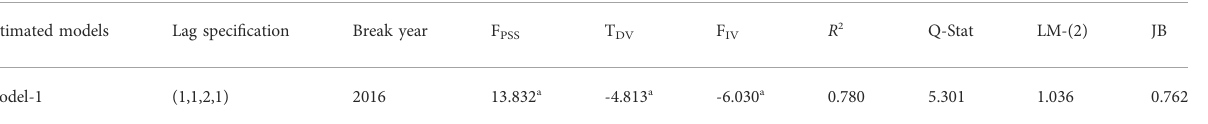
TABLE 5 Outcomes of Bootstrap ARDL cointegration